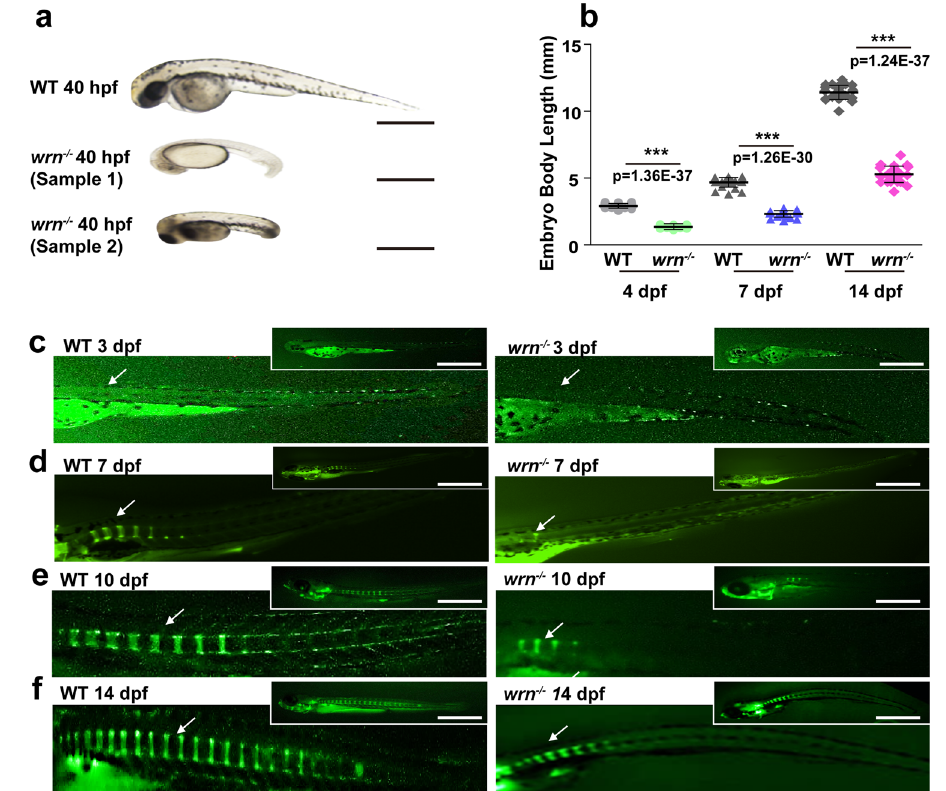
Fig. 1 | The wrn mutant zebra fi sh exhibit shortened body length. a Representative bright- fi eld images of 3 independent experiments between WT and wrn − / − mutant zebra fi sh at 40hpf. Scale bar=100 µ m. b Dot graph analysis of the total body length of WT and wrn − / − mutants from 4dpf to 14dpf. N =25 inde- pendent embryos for WT and wrn − / − mutants, respectively. Each dot represents a